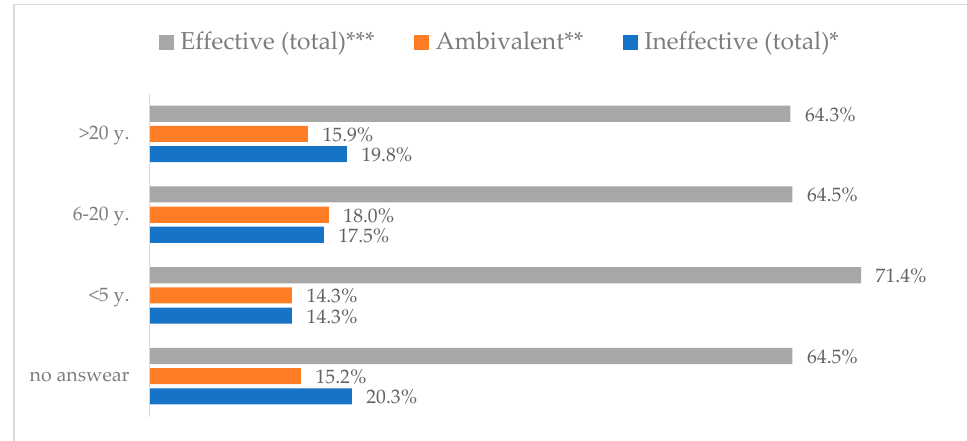
Figure 4. Wearing a protective mask that covers the mouth and nose to prevent influenza virus infection by profession ( N = 905). * Sum of responses: completely ineffective, ineffective, rather ineffective; ** Response: neither ineffective nor effective; *** Sum of responses: rather effective, effective, completely effective.